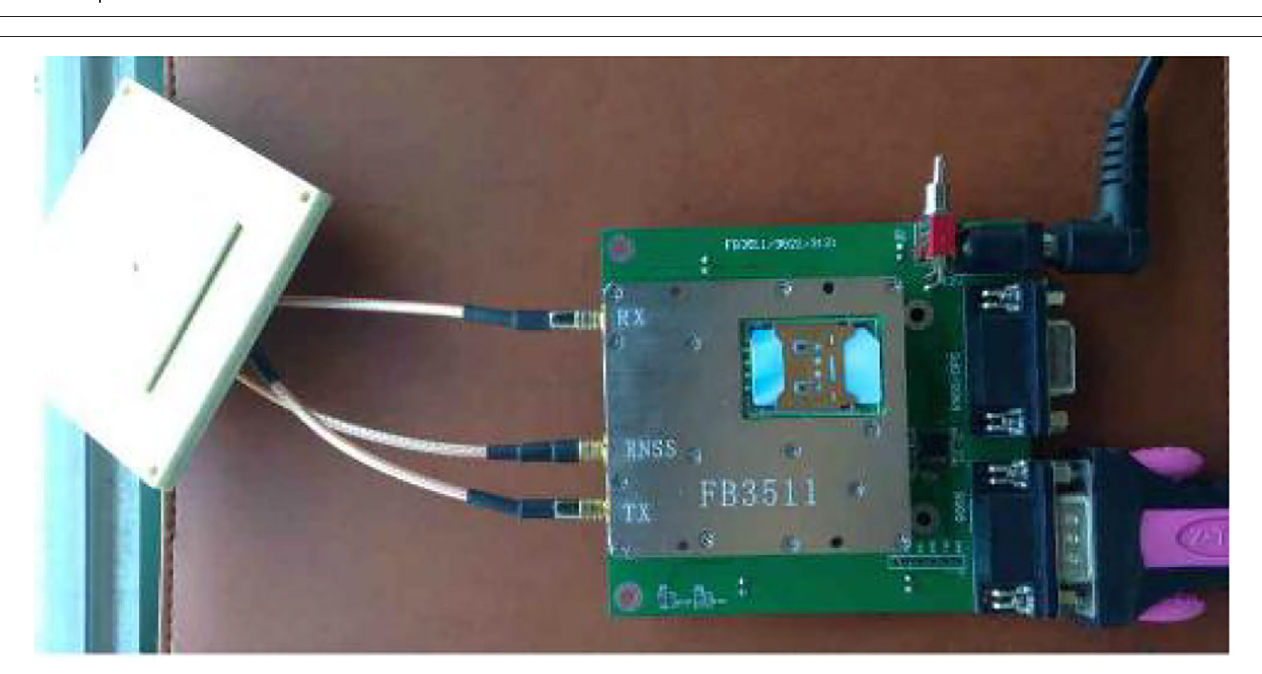
FIGURE 5 | Beidou terminal function service flow chart.